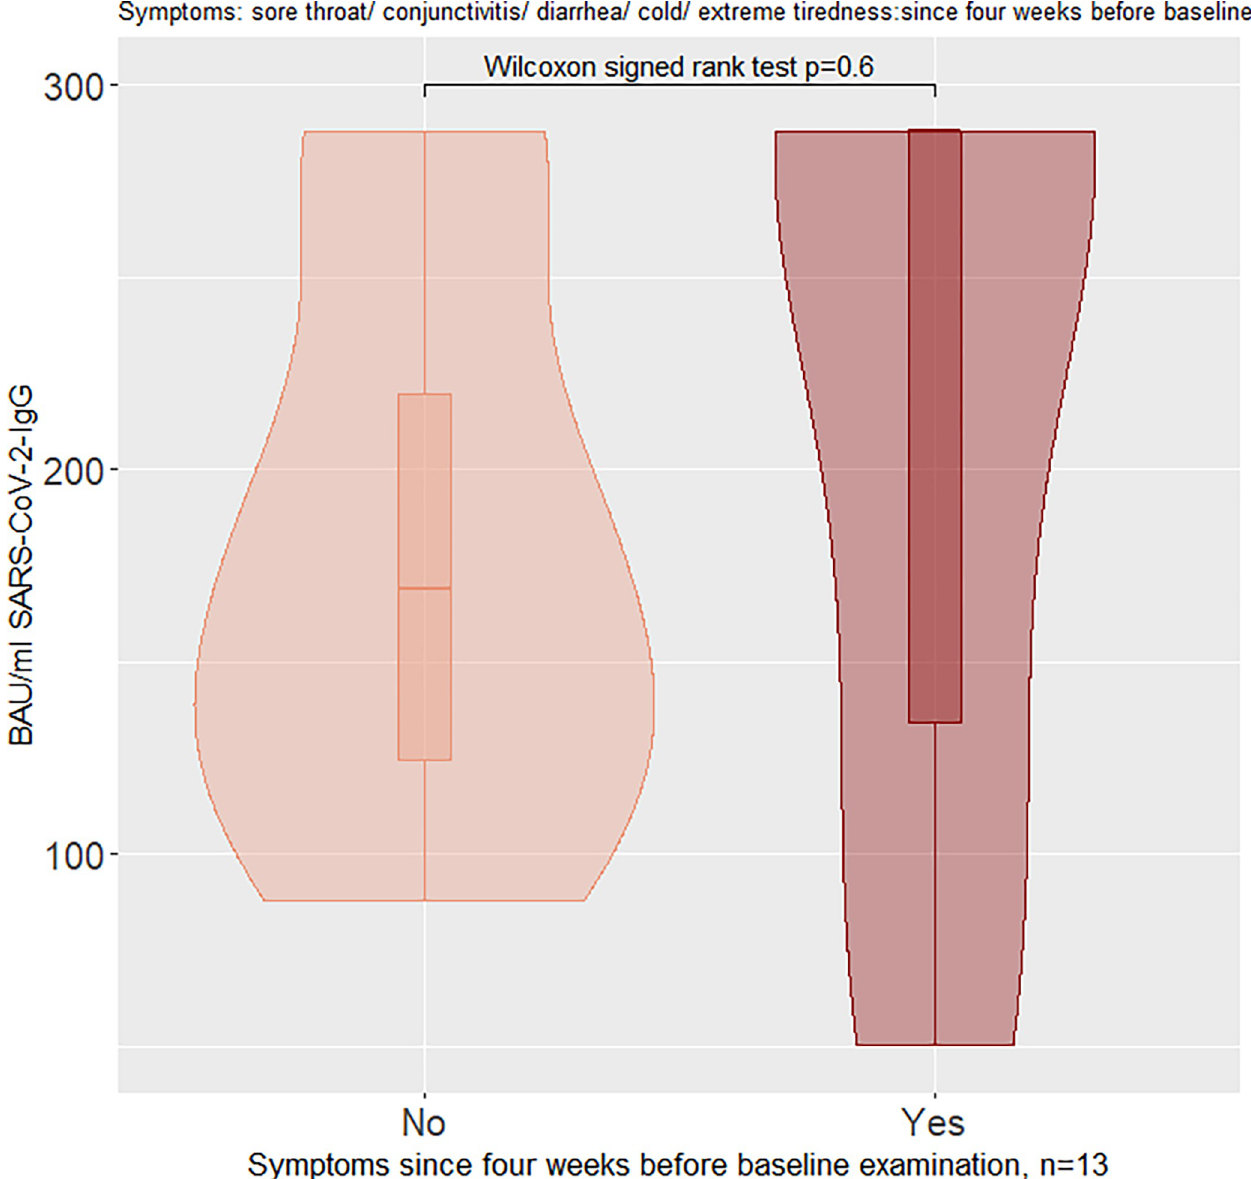
Fig 6. Violin plot of SARS-CoV-2-IgG antibodies in BAU/ml at baseline (Euroimmun 1 ELISA), stratified for symptomatic and asymptomatic children: Symptoms four weeks before baseline examination.